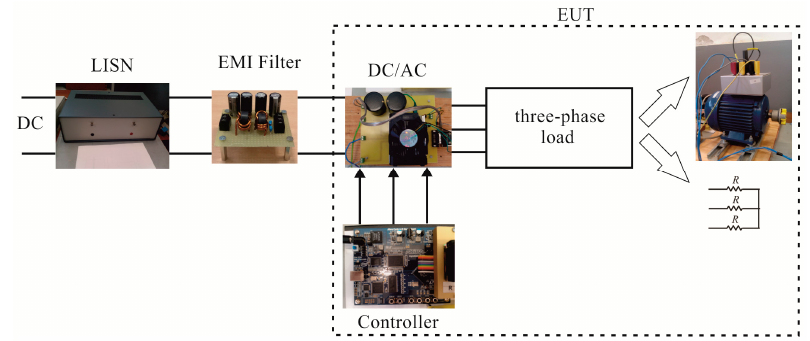
Figure 3. Block diagram of the experimental rig.